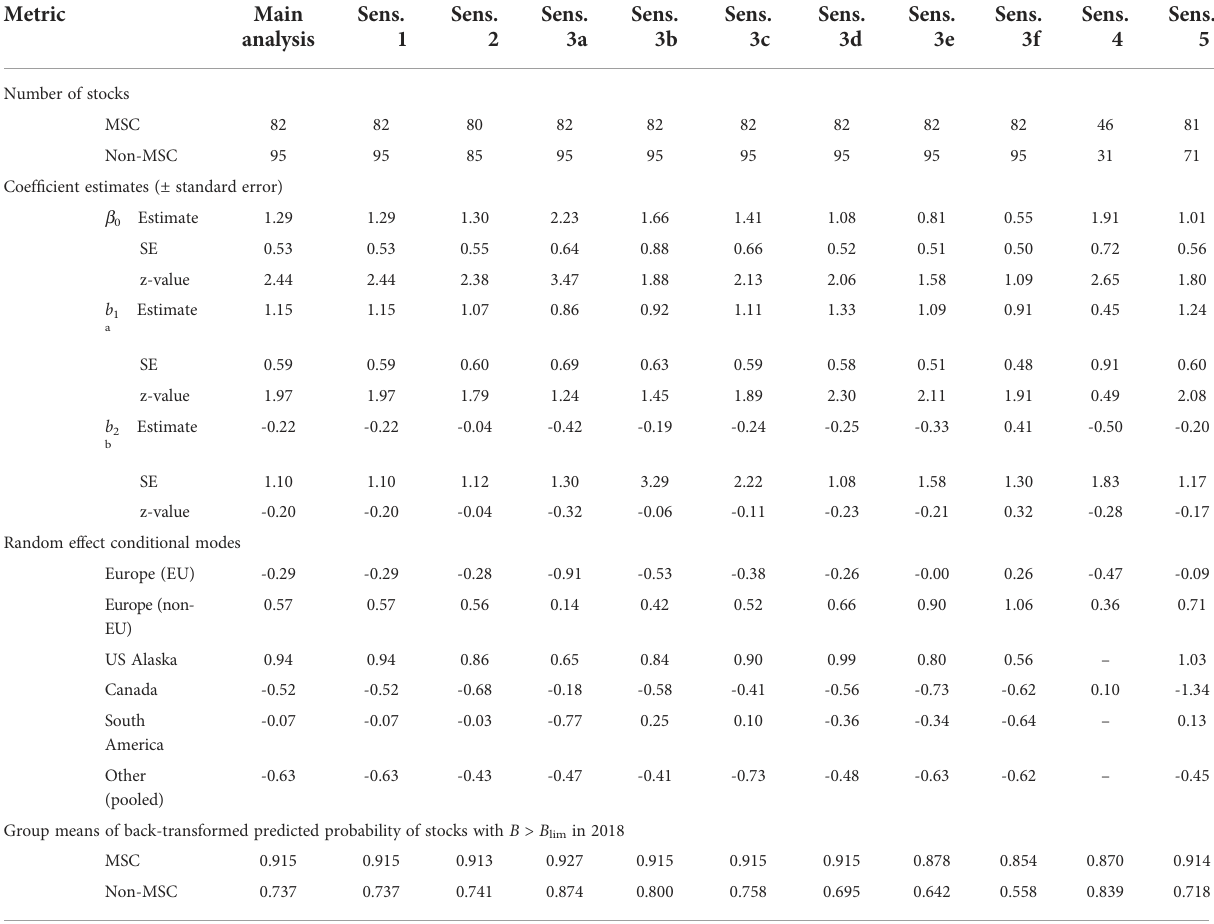
TABLE 3 Generalized linear mixed-effect model results from main analysis and sensitivity analyses for portion 1 of the analysis, comparing the proportion of stocks with B > B lim in 2018 between MSC stocks and non-MSC stocks.